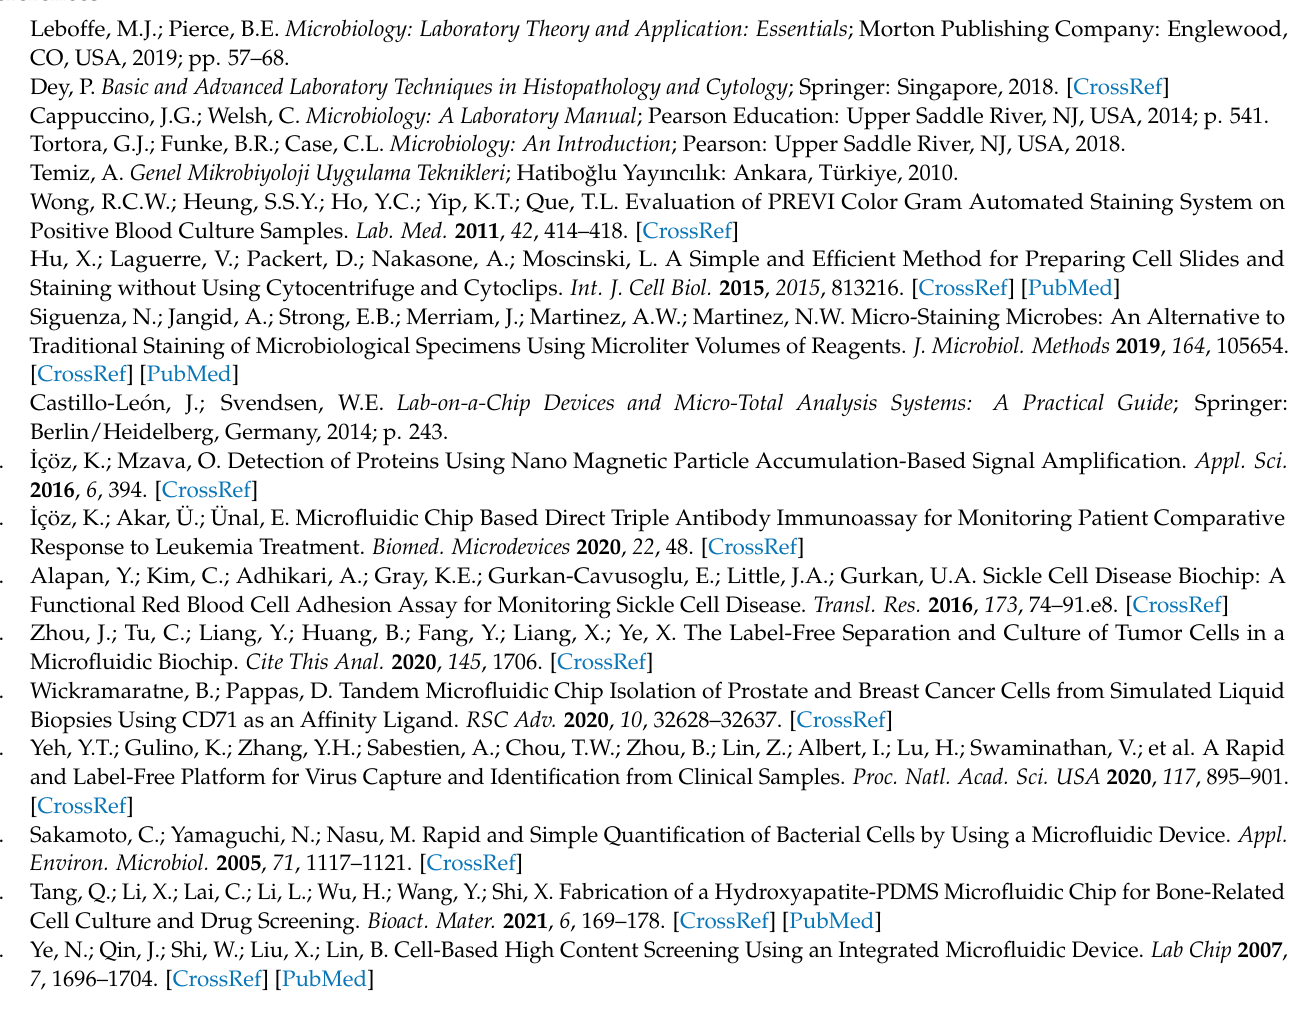
results; Figure S7: Flow cytometry analysis results for MDA-MB-231 cell line; Figure S8: Flow cytometry analysis results for Jurkat cell line; Figure S9: Microscopic images (50x) of K562 cells stained with different simple